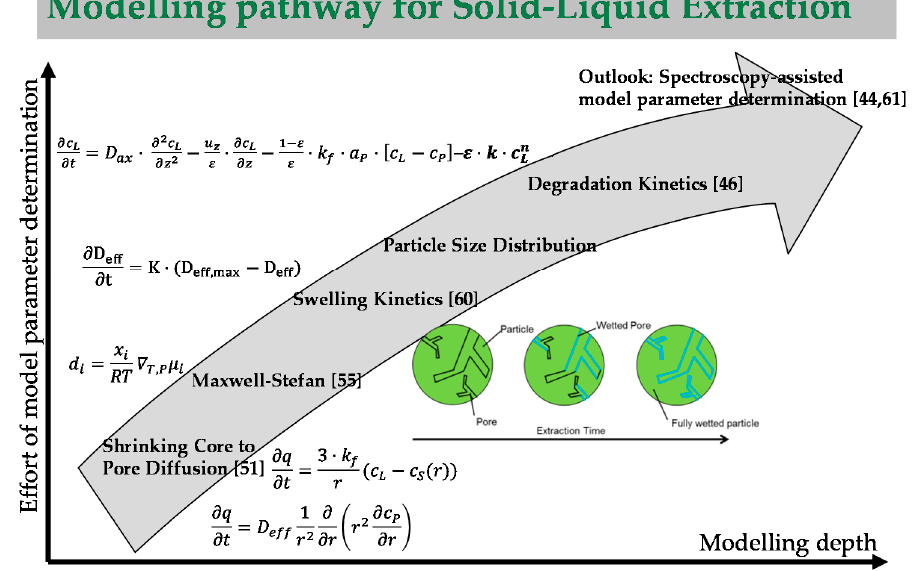
Figure 6. Effort of experimental model parameter determination at increasing modelling depth.